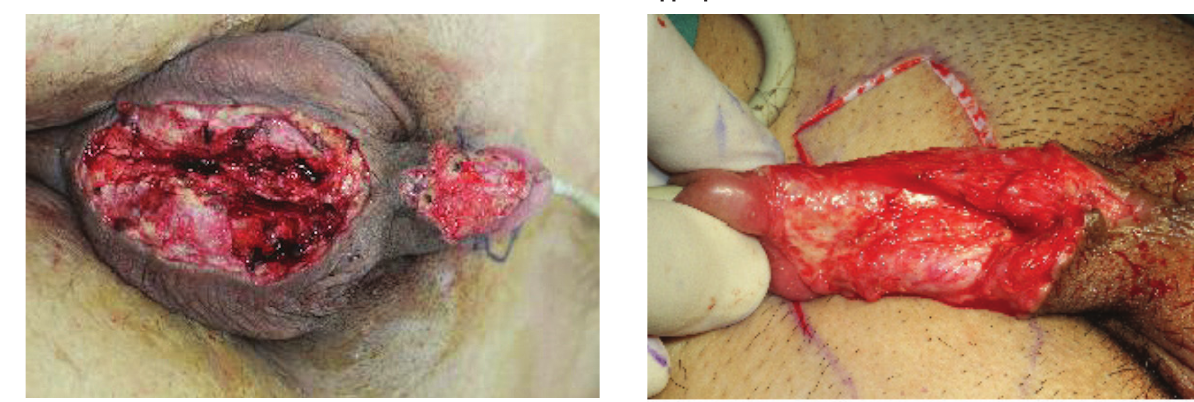
Figure 1 - Defect after debridement.